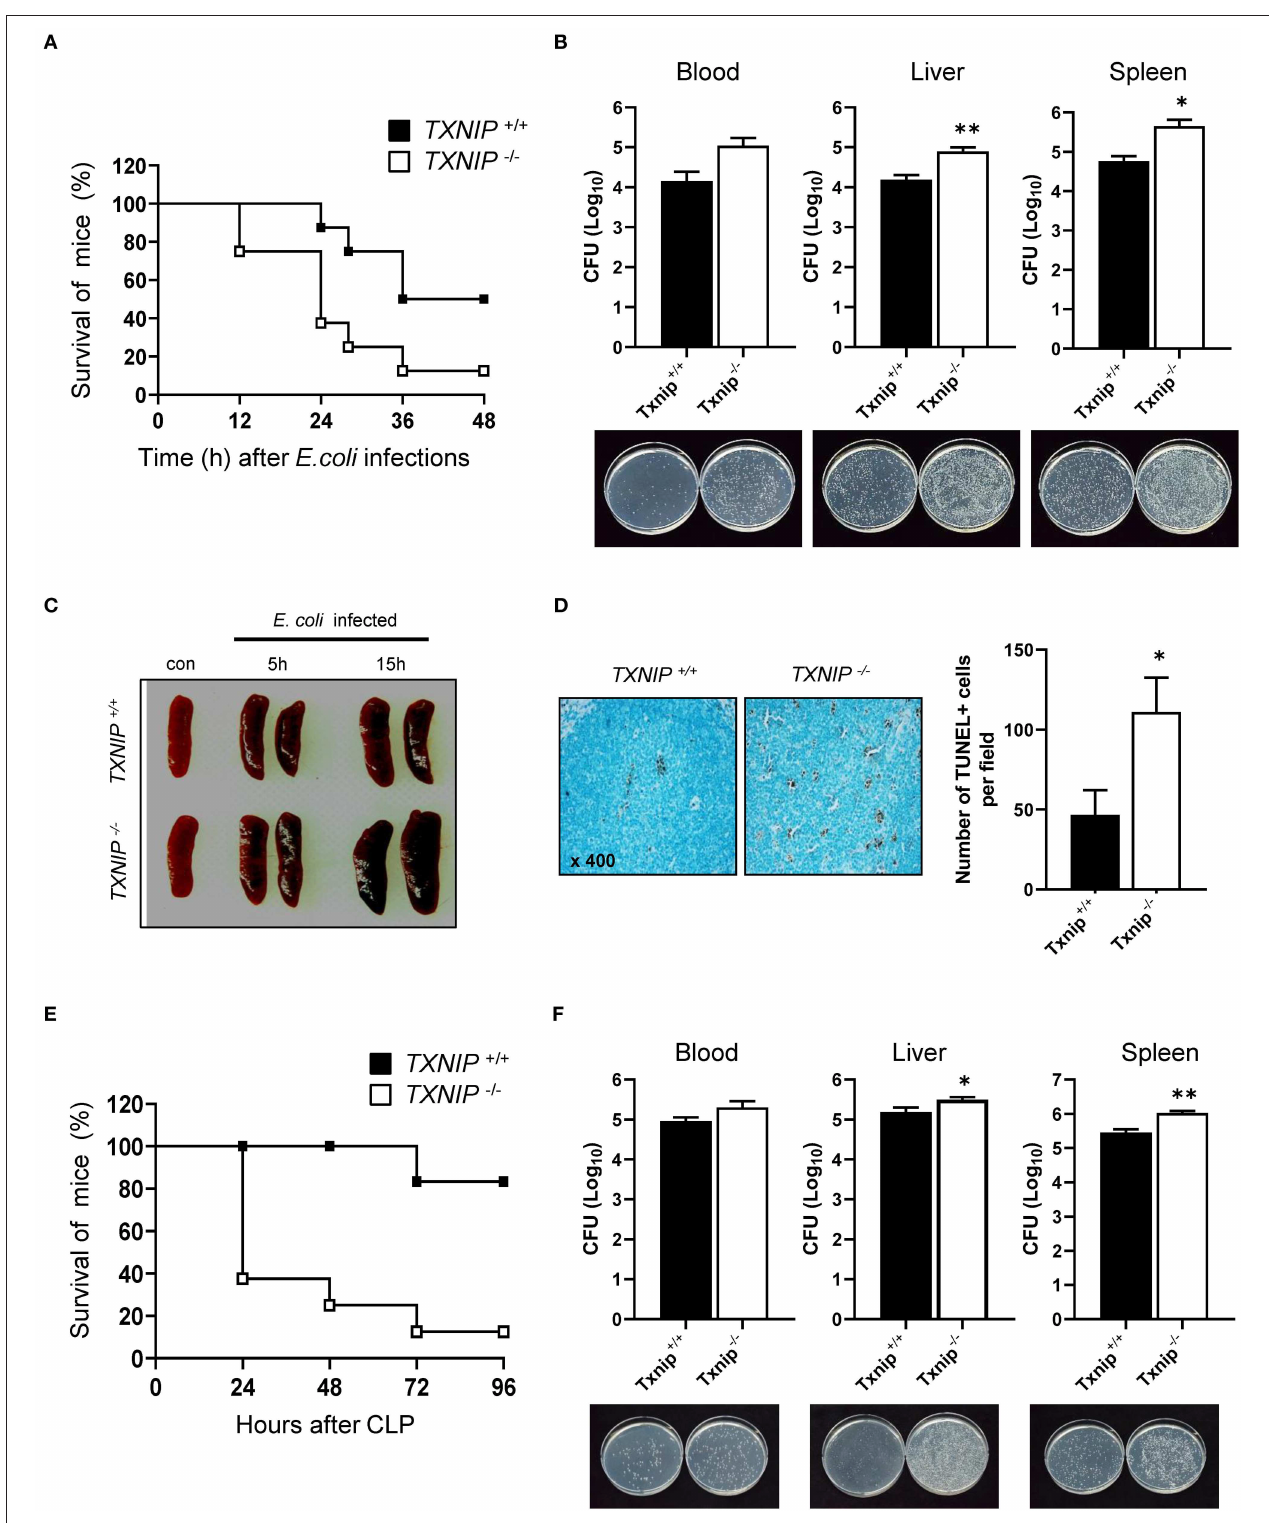
FIGURE 5 | Bacterial clearance is reduced in thioredoxin-interacting protein ( Txnip ) knockout (KO) mice. (A) Survival of wild-type (WT) and Txnip KO mice after intraperitoneal injection with E. coli (10 8 CFU, mice n = 10). (B) Colony-forming units (CFUs) and representative images of LB agar plates after overnight incubation with extracts of blood, liver, and spleen from WT and Txnip KO mice obtained 24h after the intraperitoneal injection of E. coli . Data are expressed as the mean ± SD